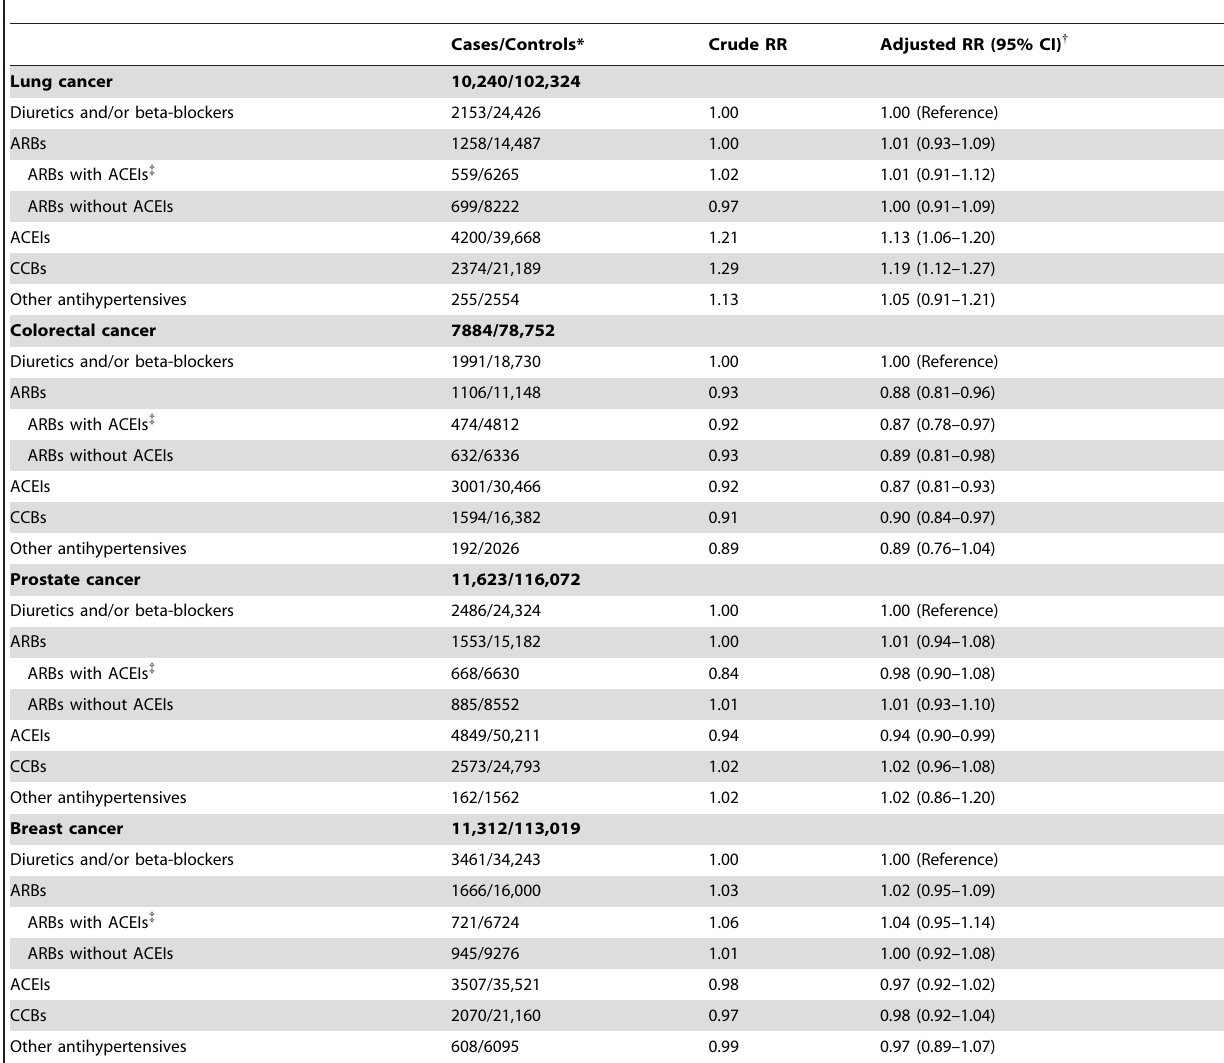
Table 3. Crude and adjusted rate ratios of lung, colorectal, prostate and breast cancer associated with antihypertensive agents relative to diuretic and/or beta-blocker